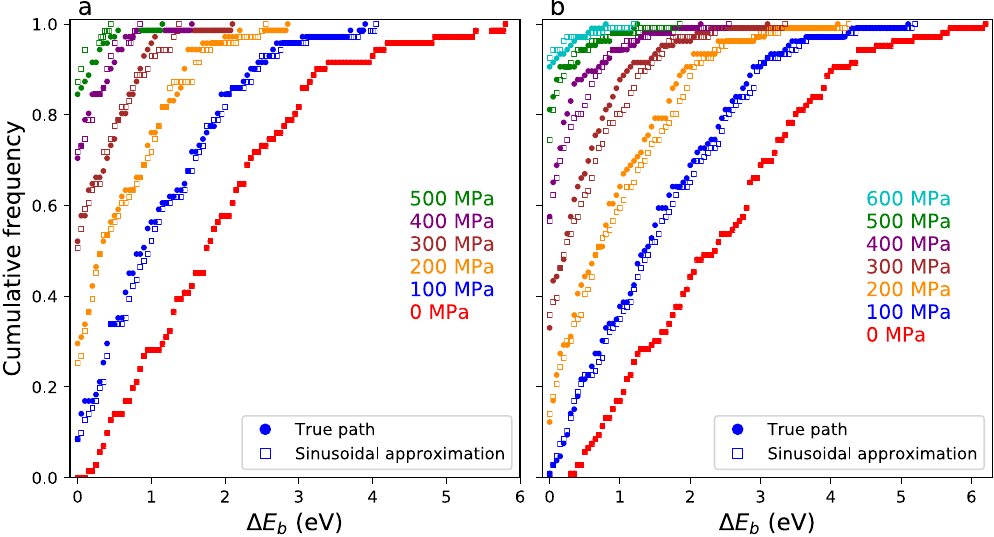
Fig. 6 Cumulative probability distribution of energy barriers versus applied shear stresses. The barriers are computed using the NEB energy landscape E ( x ) for a NbTaV and b MoNbTaW. The same distribution computed using the theoretical sinusoidal model for the local barrier is also shown, and agrees